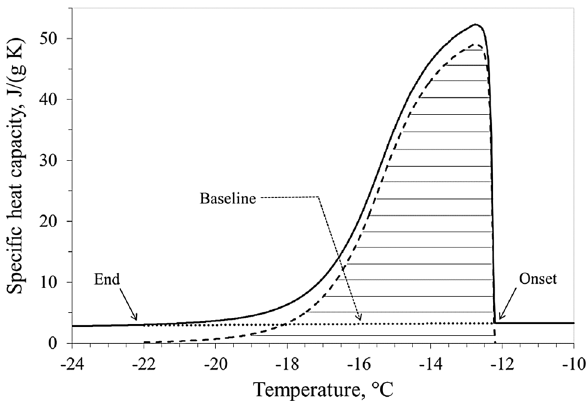
Figure 2. Measured and equivalent specific heat capacity vs temperature during the phase transition, obtained from DSC signal and sample temperature history shown in Fig. 1.